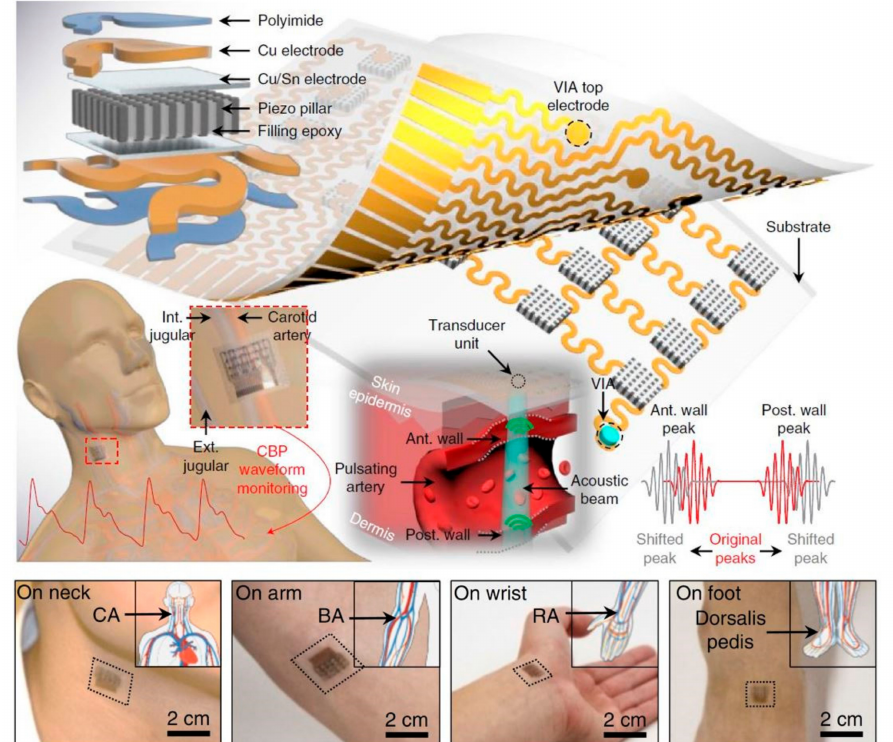
Figure 3. Stretchable ultrasonic device to identify and capture arterial blood-pressure waveforms. The high-performance 1–3 composite with piezoelectric microrods embedded in an epoxy matrix suppresses shear vibration modes and improves ultrasonic penetration into the skin. The wearable device can monitor peripheral vessel hemodynamics at di ff erent locations, for example, to sites of the brachial, radial, femoral or dorsalis pedis arteries. Reproduced with permission from Wang, C.; et al. Monitoring of the central blood pressure waveform via a conformal ultrasonic device; Springer Nature, 2018